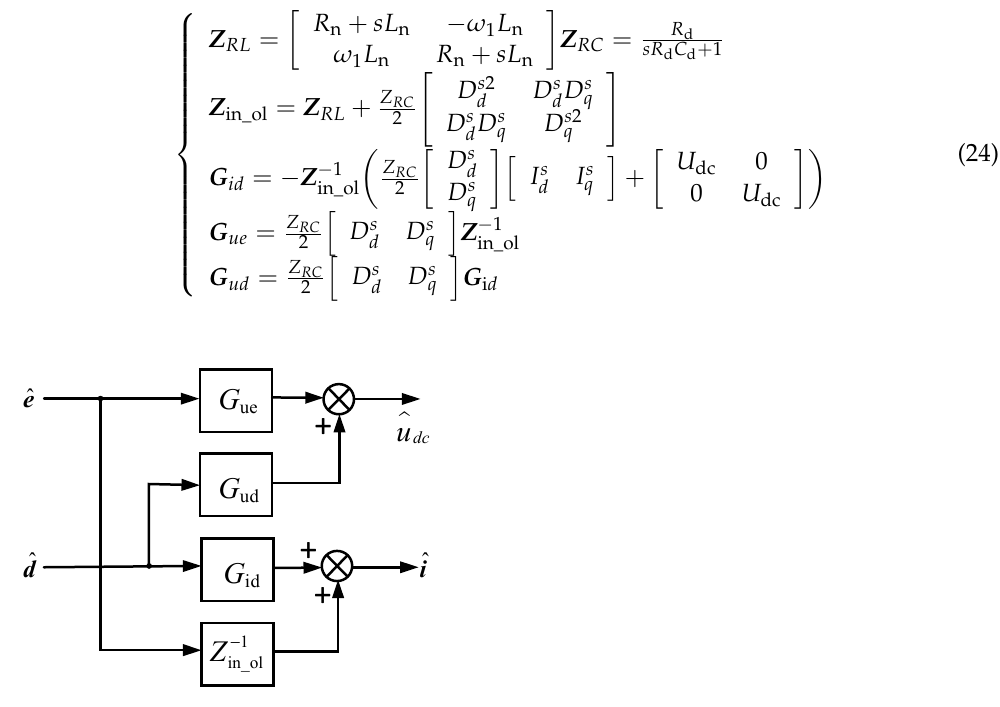
Figure 5. Small-signal matrix model of the main circuit.